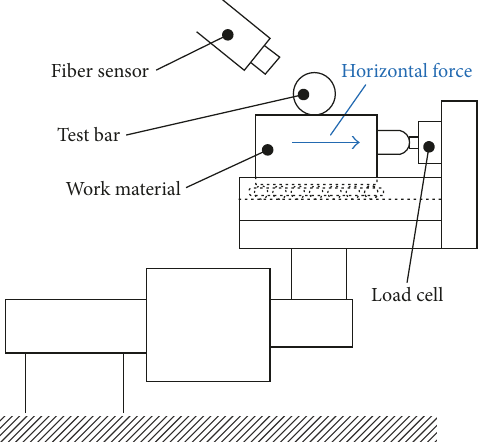
Figure 6: Schematic of experimental